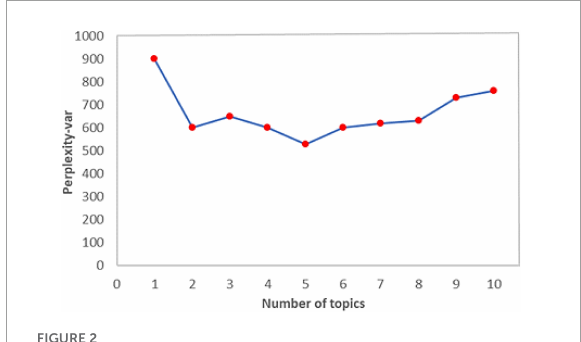
FIGURE2 Perplexity-Var values of different topic